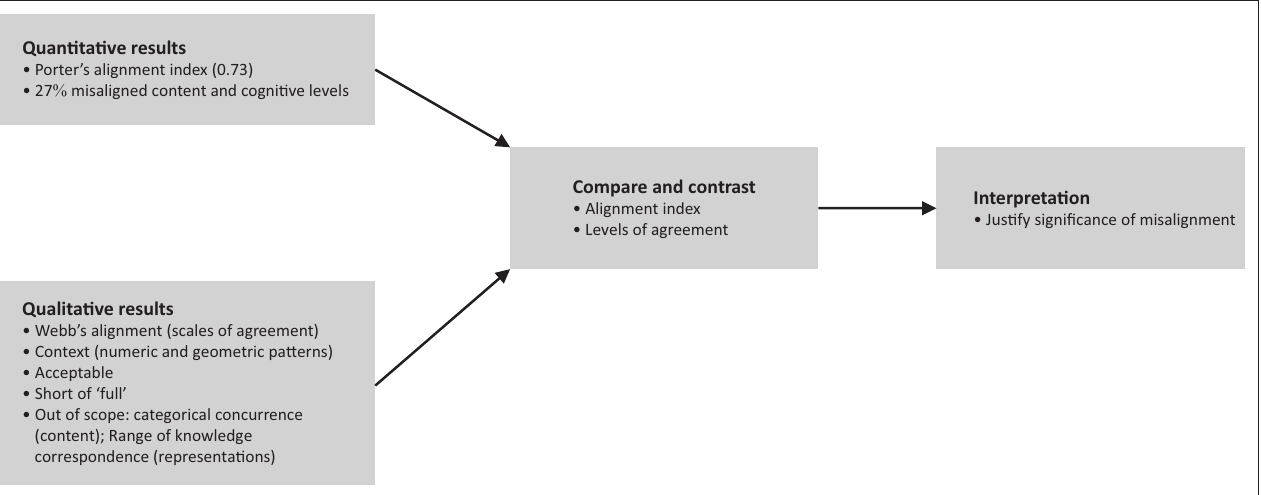
FIGURE 5: The convergence of the